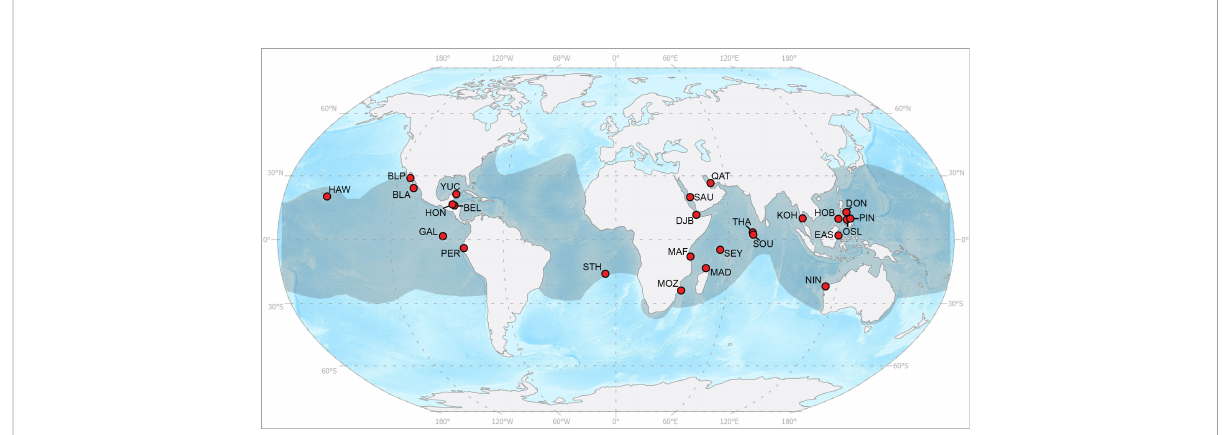
FIGURE 1 Global whale shark sites used in the present study from west to east on the map: Hawai'i, USA (HAW); Bah ı ́ a de La Paz, Mexico (BLP); Bah ı ́ a de Los Angeles, Mexico (BLA); the Galapagos Islands, Ecuador (GAL); Utila, Honduras (HON); Belize (BEL); Yucatan Peninsula, Mexico (YUC); Peru (PER); St. Helena, UK (STH); Tofo, Mozambique (MOZ); Ma fi a Island, Tanzania (MAF); Al Lith, Saudi Arabia (SAU); Gulf of Tadjoura, Djibouti (DJI); Nosy Be, Madagascar (MAD); Al Shaheen, Qatar (QAT); the Seychelles (SEY); Thaa Atoll, the Maldives (THA); South Ari Atoll, the Maldives (SOU); Koh Tao, Thailand (KOH); Ningaloo Reef, Australia (NIN); East Kalimantan, Indonesia (EAS); Honda Bay, Philippines (HOB); Oslob, Philippines (OSL); Donsol, Philippines (DON); and Pintuyan, Philippines (PIN). The shaded area represents the species range, adapted from the IUCN Red List assessment (Pierce & Norman, 2016). Map produced using ESRI ArcGIS Pro using the 1:50 m Ocean Bottom and the 1:110 m Land datasets from Natural